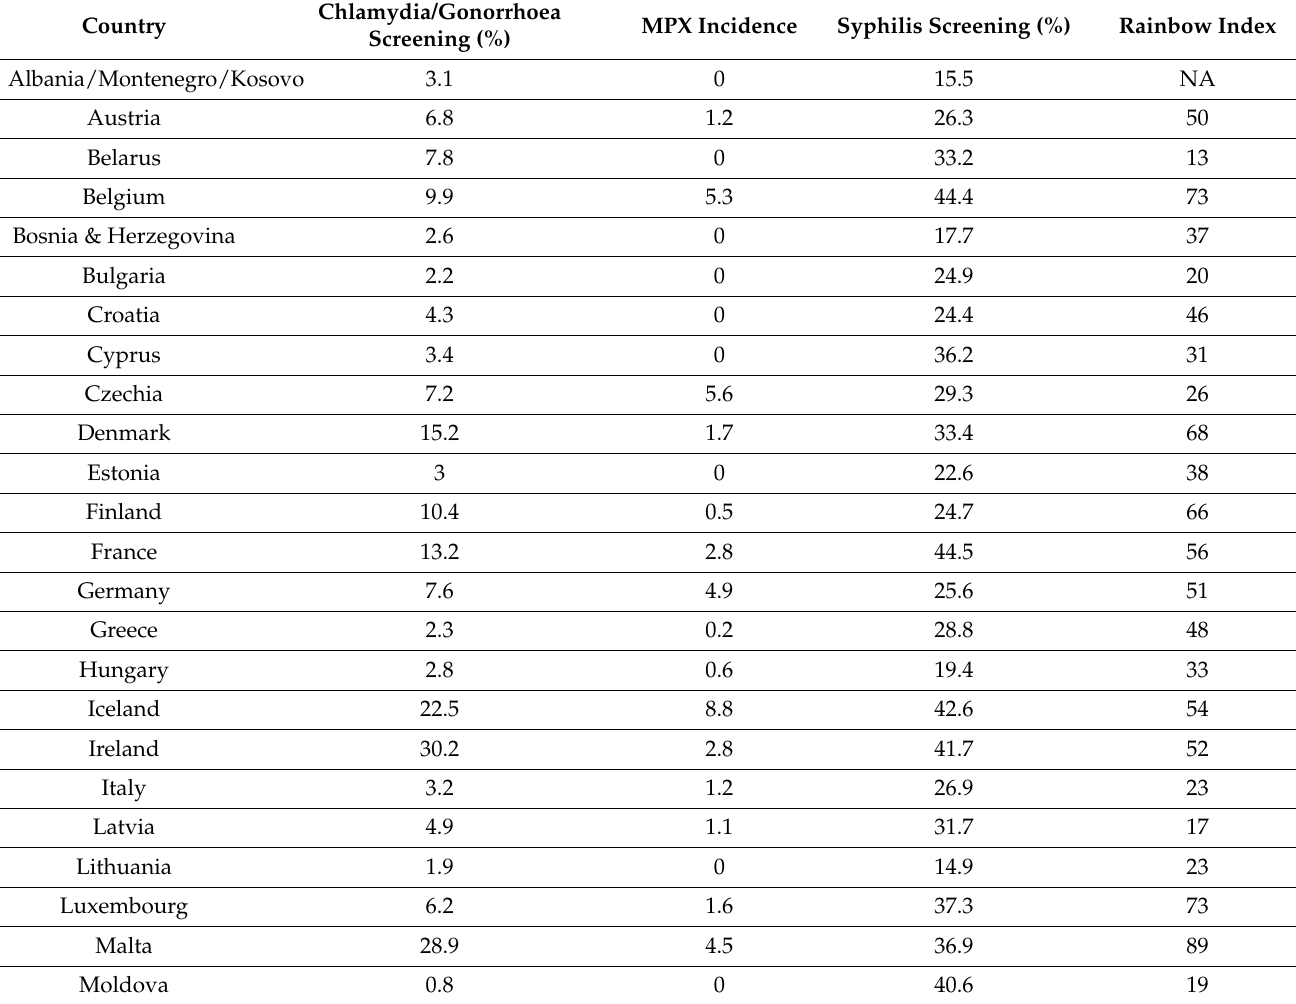
Table 1. Country-level cumulative incidence of monkeypox (MPX, cases per million 6 May 2022–22 May 2022) and intensity of STI screening and value of the Rainbow